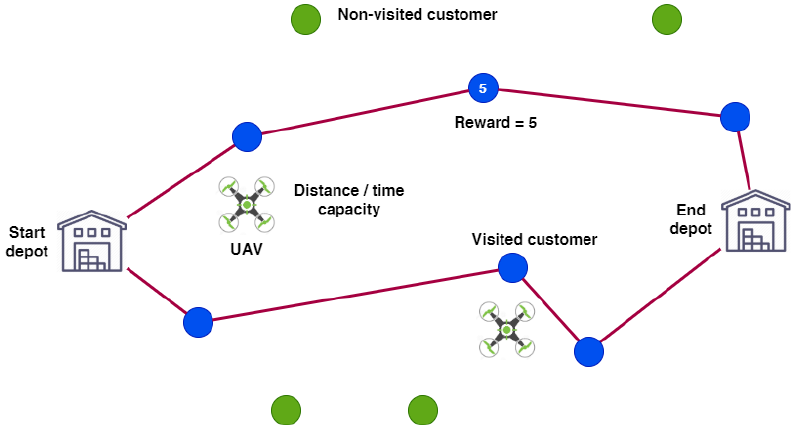
Figure 5. Visual representation of a basic